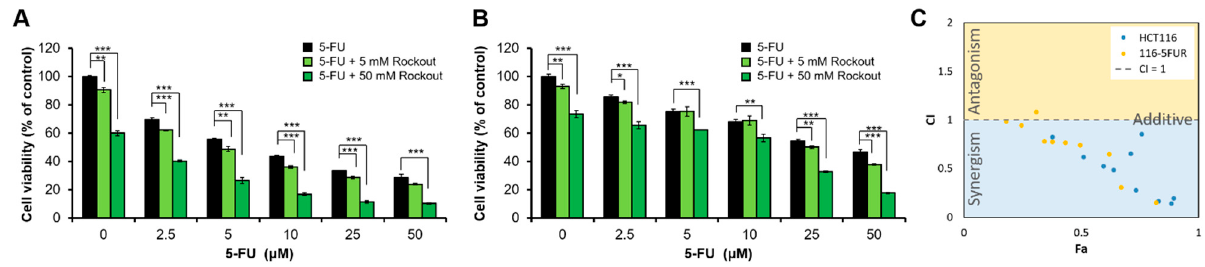
Figure 5. ROCK inhibitor synergizes 5-FU effects on resistant cells: ( A ) HCT116 and ( B ) 116-5FUR cells were treated with Rockout and 5-FU at the indicated doses. We measured the cell viability by MTS assay and normalized it to DMSO vehicle control. Grass green and green bars are cell viability of ROCK inhibitor Rockout-treated cells at different dosages compared with 5-FU alone treated cell viability. *, p < 0.05; **, p < 0.01; ***, p < 0.001. ( C ) Quantitation of synergism and antagonism in Rockout inhibitor and 5-FU combination. Fa versus CI plots were generated by CompuSyn. CI indicates a greater/synergism (CI < 1), lesser/antagonism (CI > 1), or similar (CI = 1) effect than the expected additive effect. Table 1. Predicted drugs list for setback gene expression of drug-resistant traits. Rank Perturbation